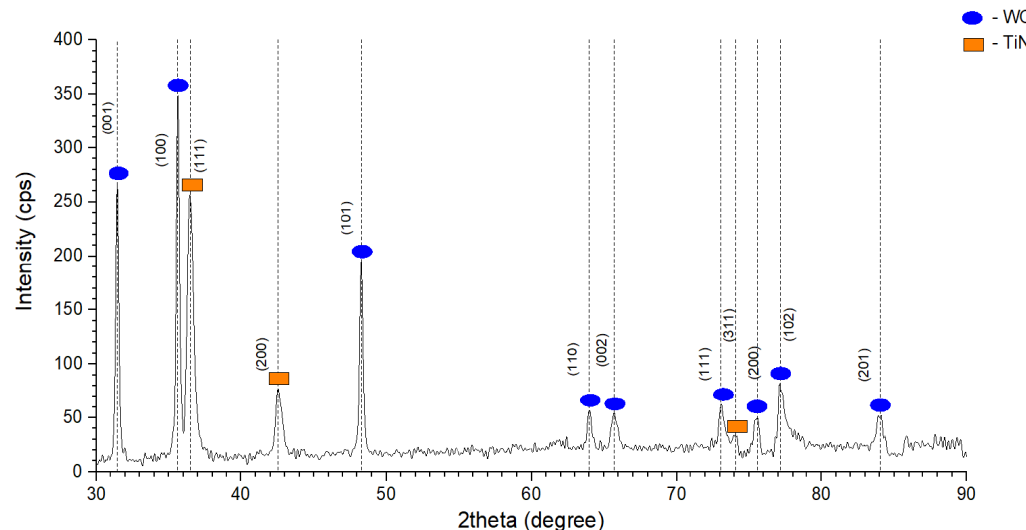
Figure 5. The representative XRD patterns of the MCT-TN.